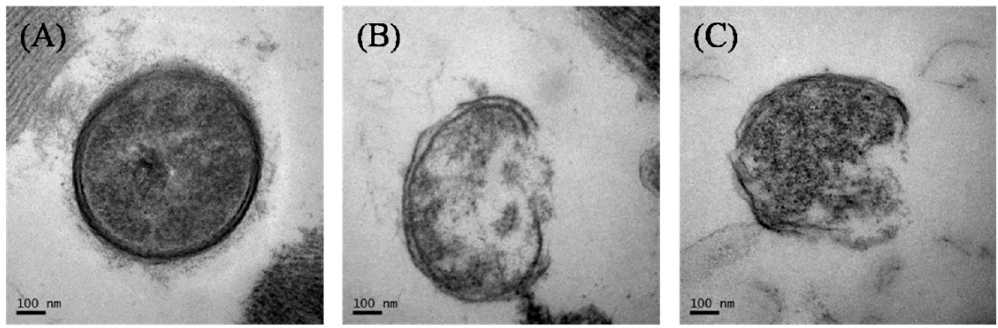
Figure 5. TEM images of Salmonella treated with 0 ( A ), 50 ( B ), and 100 mg/L ( C ) of chlorine.